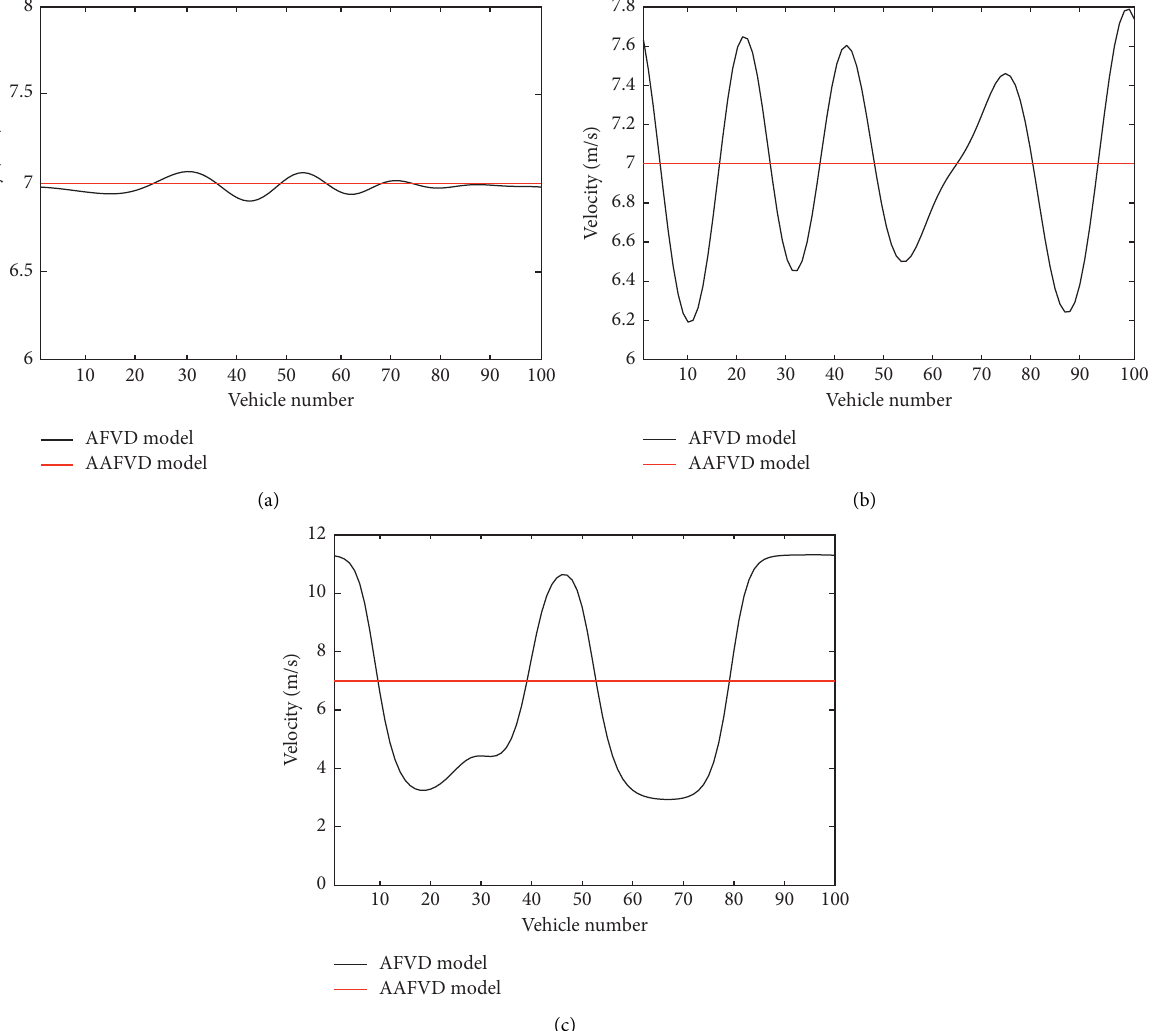
Figure 10: A mixed platoon of one hundred vehicles including CA vehicles platoon and HD driving vehicles moving forward on a circuit road with the path distance of D �